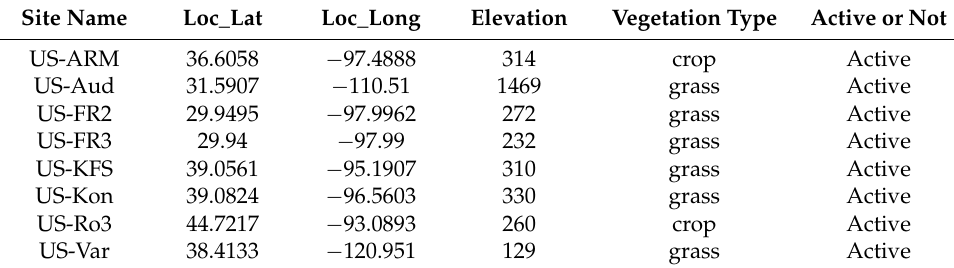
Table 1. Flux sites used in this